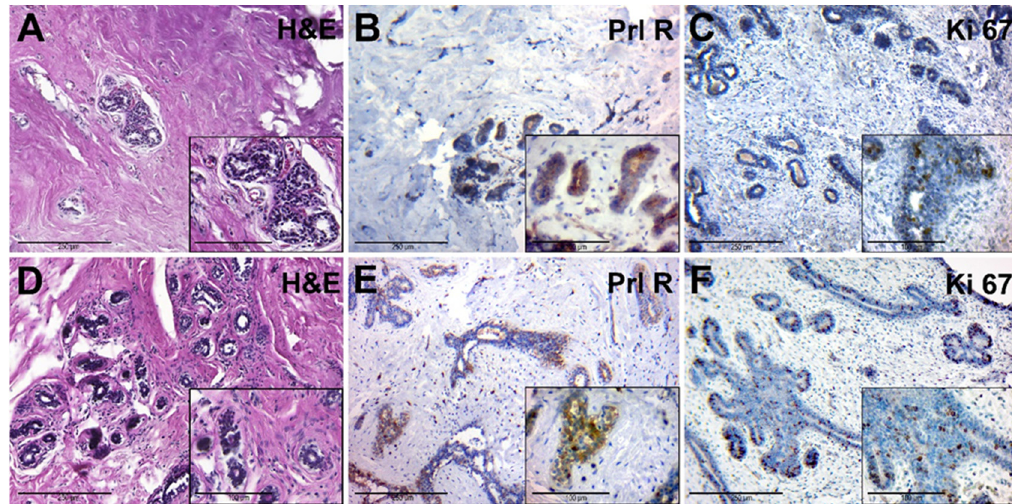
Figure 4. Histological and immunohistochemical examination of tissue samples from patients with elevated levels of serum PRL. ( A – C )—adjacent breast tissue of patients with elevated levels of serum PRL (group IIA). ( A )—hematoxylin- eosin staining; ( B )—IHC detection of PRL-R expression; ( C )—IHC expression of Ki-67. ( D – F )—BBT tissue of patients with elevated levels of serum PRL (group IIB). ( D )—hematoxylin and staining (group 2B); ( E )—IHC detection of PRL-R expression; ( F )—IHC expression of Ki-67. Magnification (including inserts) is indicated in the lower left corner of the image as a marker.